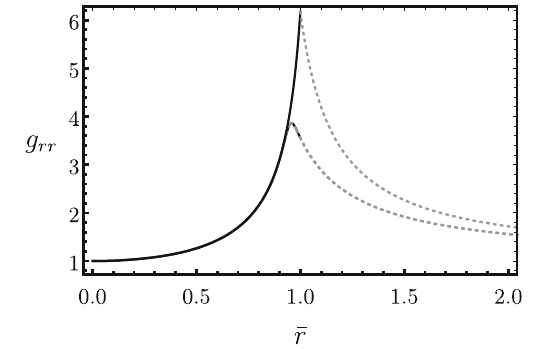
Fig. 14 g rr as a function of ¯ r in RG, for the constant density case (upper curve), and for the exponential profile, with ¯ ρ 0 = 0 . 10